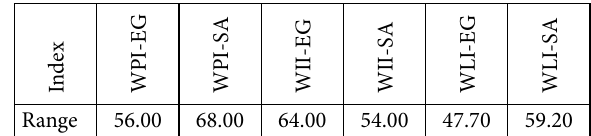
Table 7. Inputs and outputs ranges for Level 01 of the model